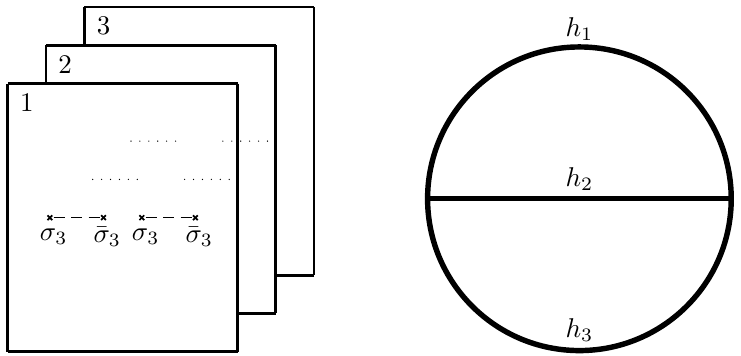
Figure 1 . Left : the 3-fold cover of the Riemann sphere with four branch points is a genus-two surface. The partition function of the CFT on the covering surface can be regarded as the four-point function of Z 3 twist (cid:12)elds in the 3-fold product CFT on the sphere. Right : the genus two conformal block associated with the (cid:27) 3 (cid:22) (cid:27) 3 OPE